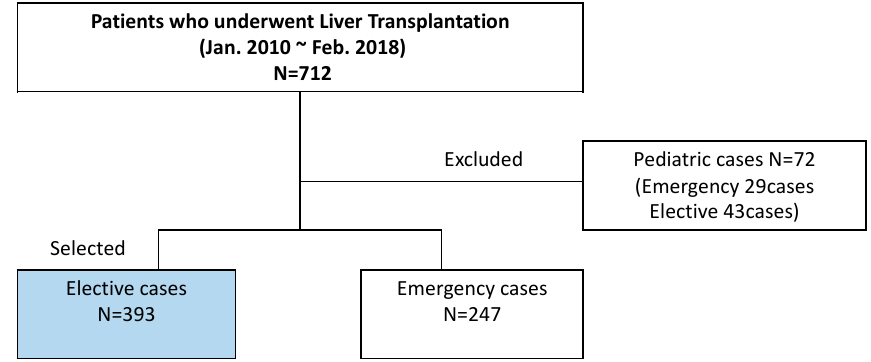
Figure 1. Schematic diagram of the patient selection process.